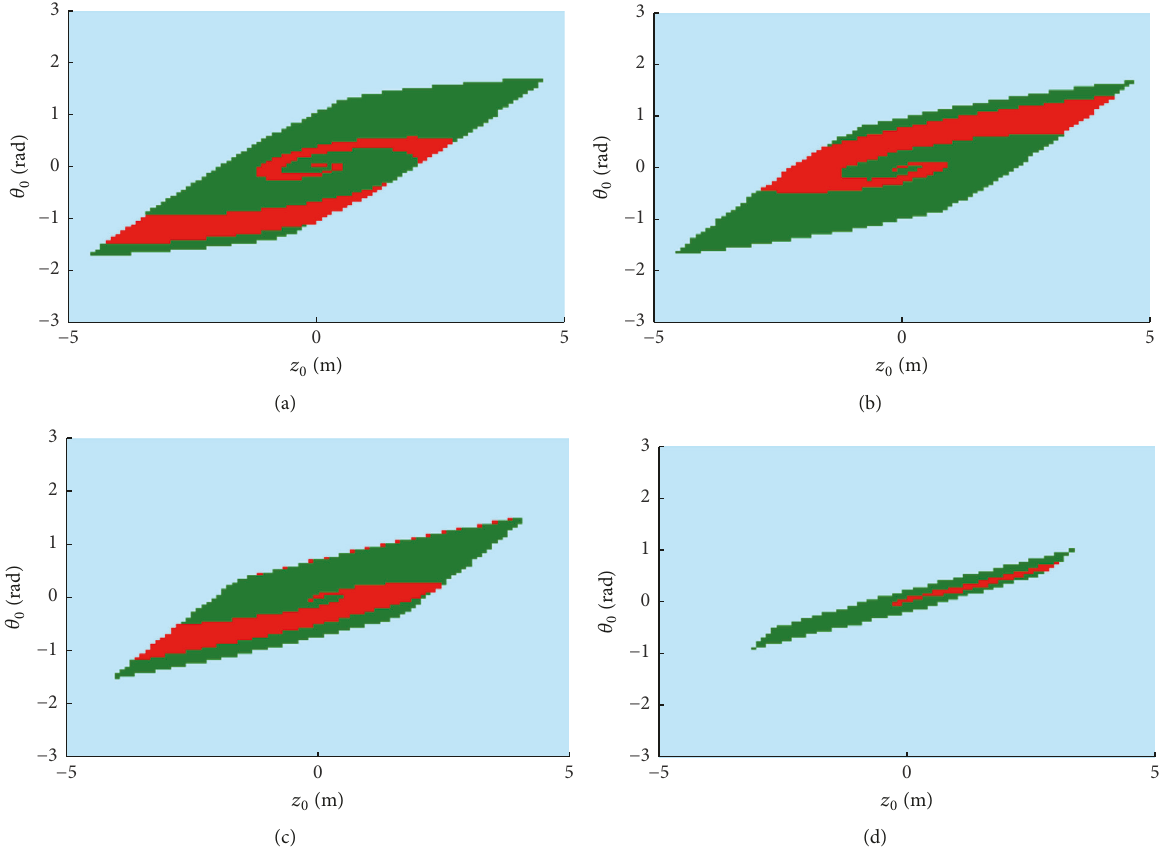
Figure 6: Basins of attraction: (a) 𝜎 = 0.02468 , 𝑘 = 3.423 ; (b) 𝜎 = 0.02603 , 𝑘 = 5.901 ; (c) 𝜎 = 0.02721 , 𝑘 = 7.473 ; (d) 𝜎 = 0.02655 , 𝑘 = 9.369